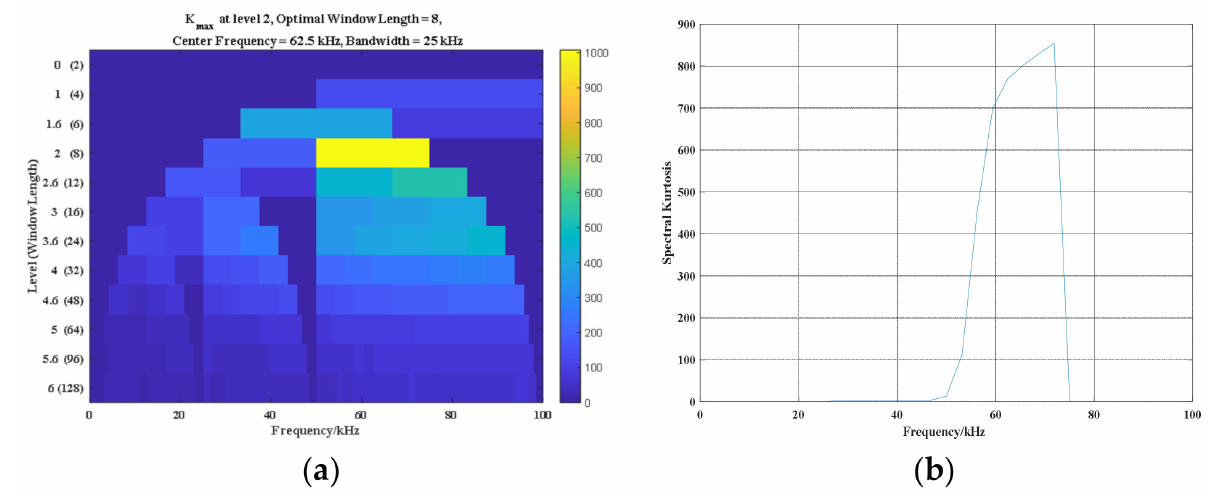
Figure 5. The kurtosis analysis diagram of the line-mode current on the M side: ( a ) kurtosis spectrum; ( b ) spectral kurtosis plot under optimal number of decomposition windows.